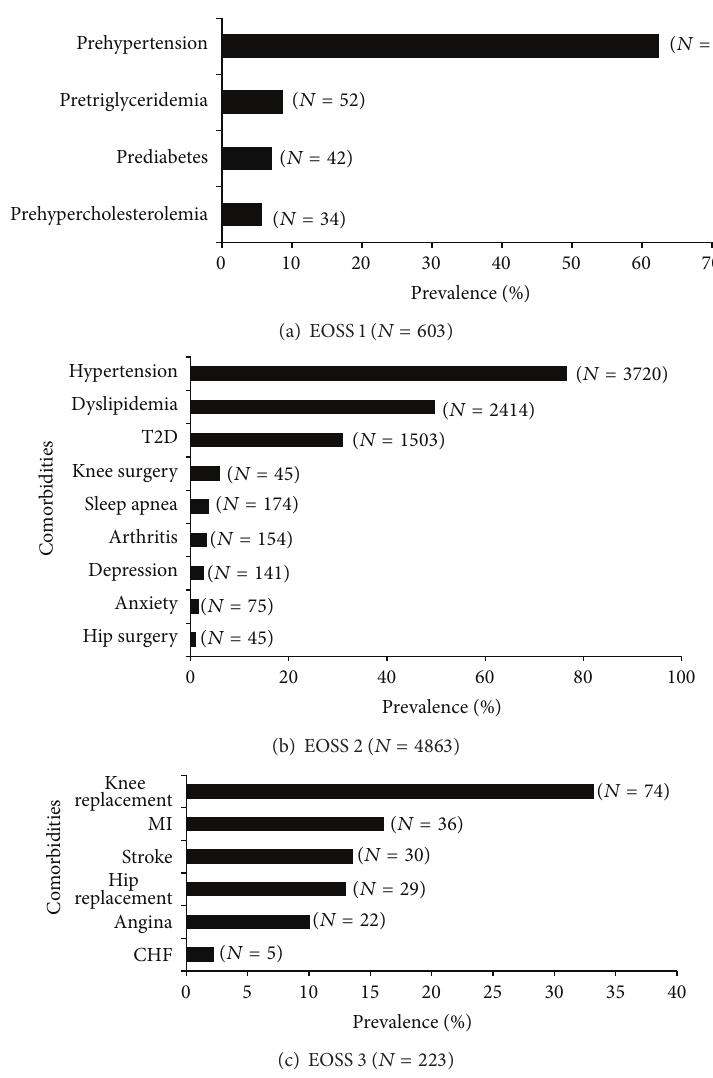
Figure 1: Prevalent comorbidities for patients in EOSS stage 1 (a), stage 2 (b), and stage 3 (c). CHF = congestive heart failure; EOSS = Edmonton Obesity Staging System; MI = myocardial infarction; T2D = type 2